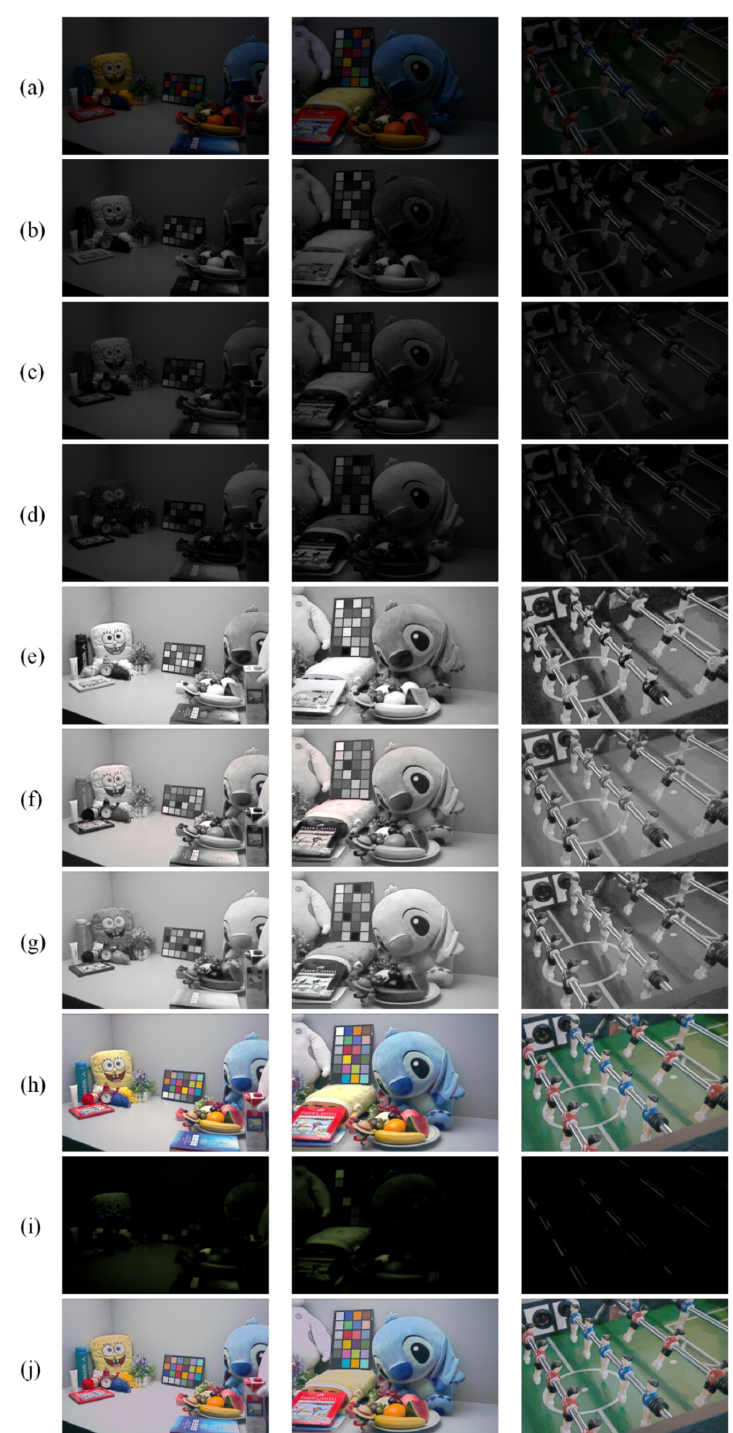
Figure 5. The example of the images used and generated in the proposed method. ( a ): the input images; ( b – d ): R, G, and B channels of the input images; ( e – g ): the enhanced R, G, and B channels; ( h ): the preliminary enhanced images I mpi ; ( i ): the residual maps I res ; ( j ) the final enhanced images I enh